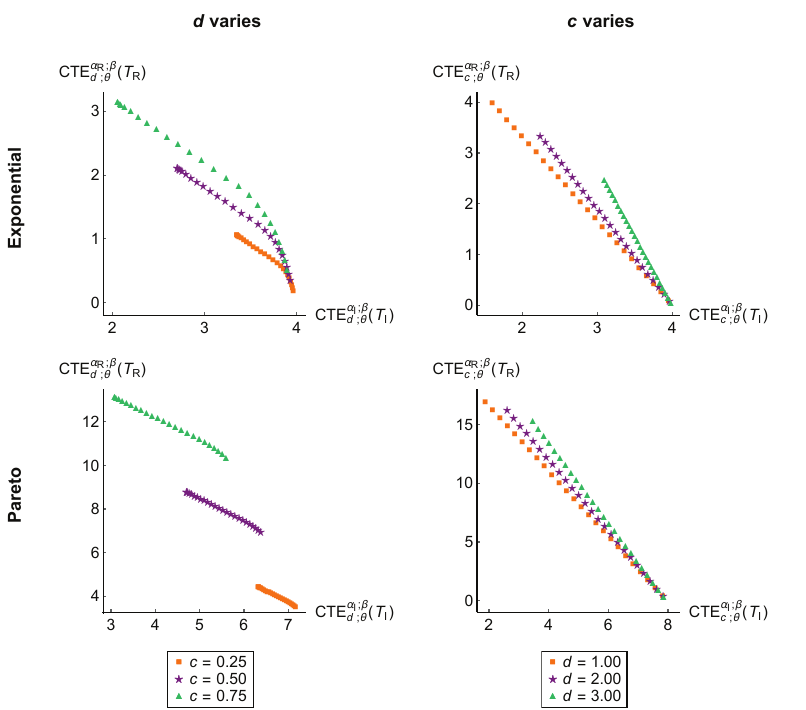
( T ) and CTE α R ; β ( T ) at the same retention values I R d , c ; θ d , c ; θ